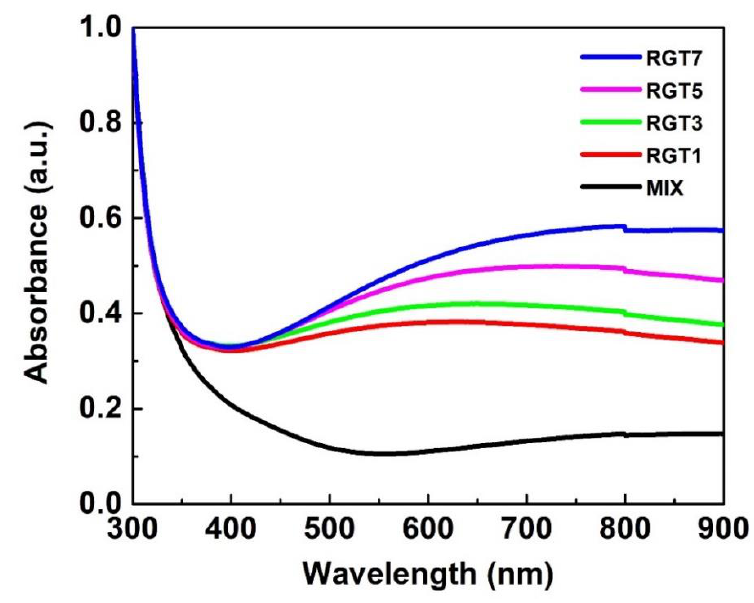
Figure 6. Absorbance spectra of HfN thin films.